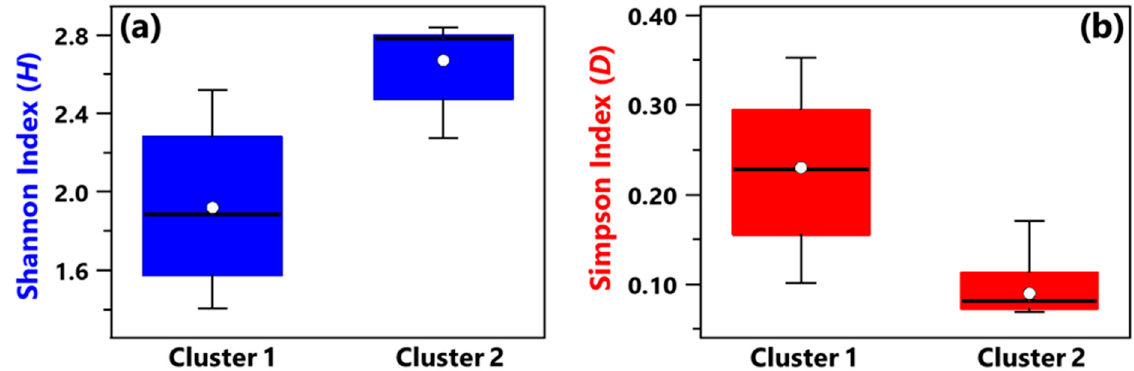
Figure 2. Boxplots displaying the ( a ) Shannon and ( b ) Simpson index value calculated at the genus level for the samples belonging to Cluster 1 (A_HR, DD1, B_R2, B_BAT, B_R1) and Cluster 2 (A_R1, HR1, PSY, RO1, RO2, HR2, DD2, R4, R3, B+C_R2, MED, B+C_R1). For each boxplot, the line within the box and the white dots represent the median and mean value, respectively. The bottom and top boundaries of each boxplot indicate the 25th and 75th percentiles, respectively. The whiskers are the 5th and 95th percentiles, respectively.